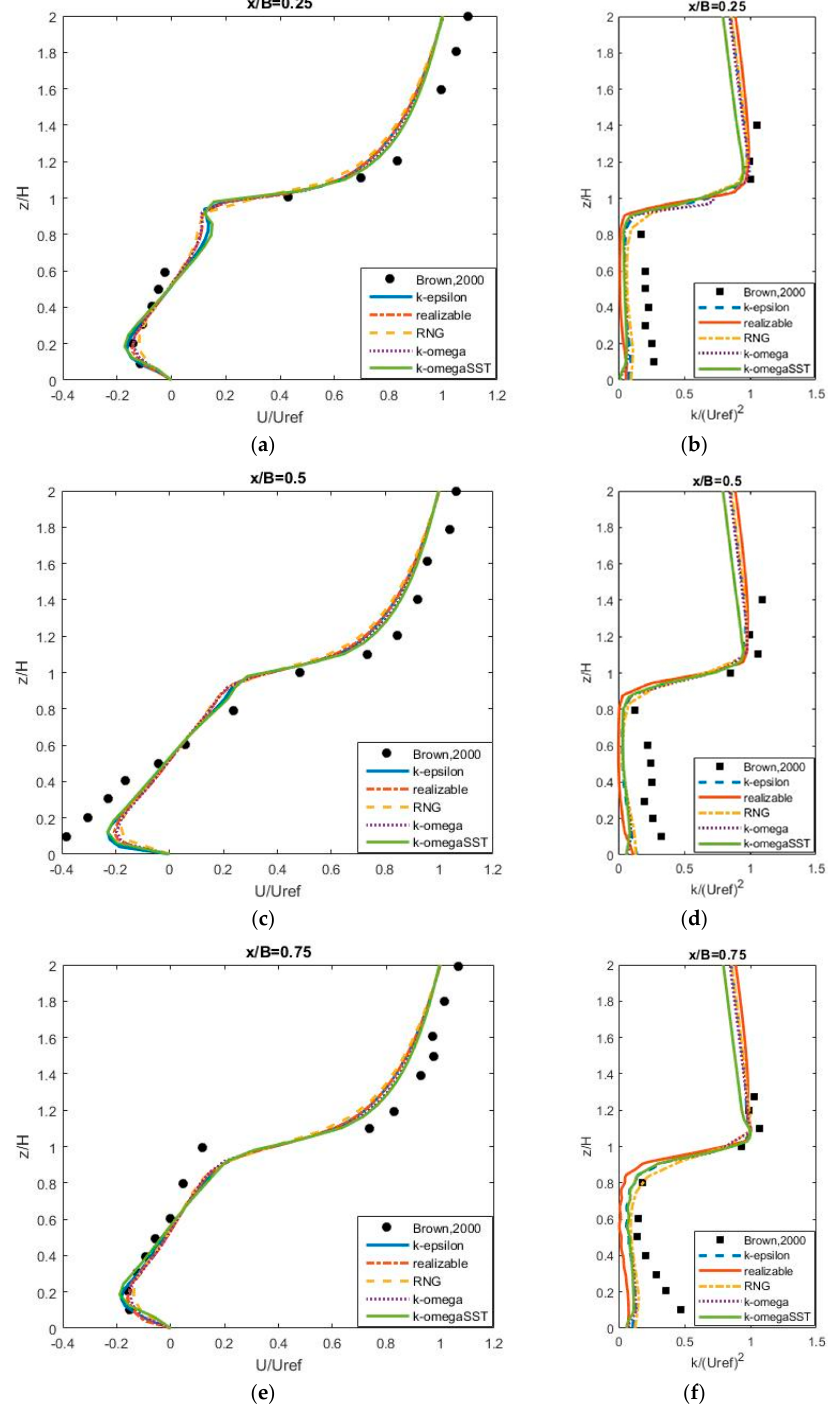
Figure 3. A comparison of vertical velocity profiles (U / U ref ) ( a , c , e ) and turbulence kinetic energy ( k/U (cid:2928)(cid:2915)(cid:2916)(cid:2870) ) ( b , d , f ) between numerical results obtained from different turbulence models and experimental data (Brown et al., [19]).